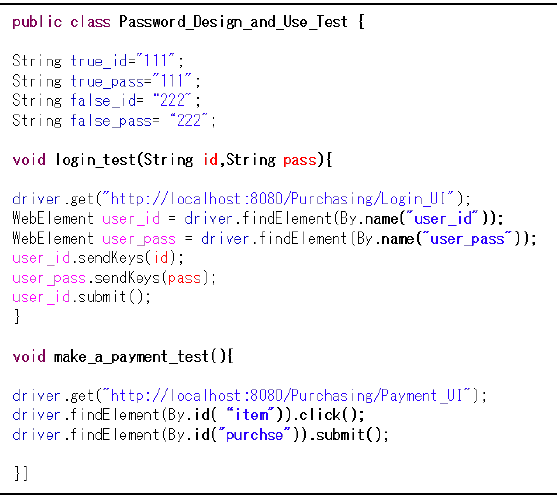
Figure 13. Part of the created test case.